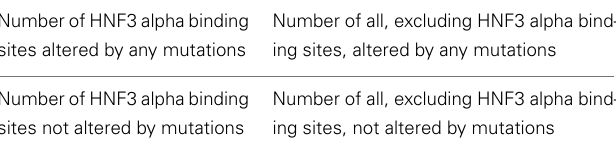
Table 4 | Example of contingency table forTF HNF3 alpha overrepresentation